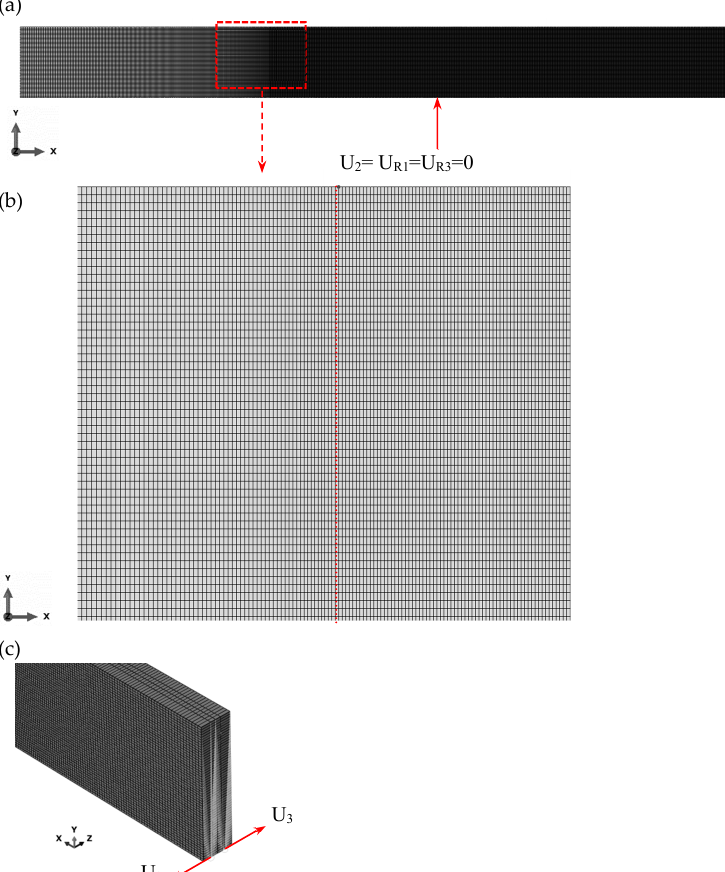
Figure 4. FE model for simulating Mode I experiment: ( a ) in-plane meshing of the model and constraints; ( b ) the mesh near the crack front marked by the red dashed line; ( c ) through-thickness mesh and kinematic coupling constraint at the tip of the DCB.